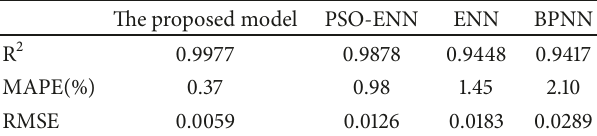
Table 8: Error analysis of the compared